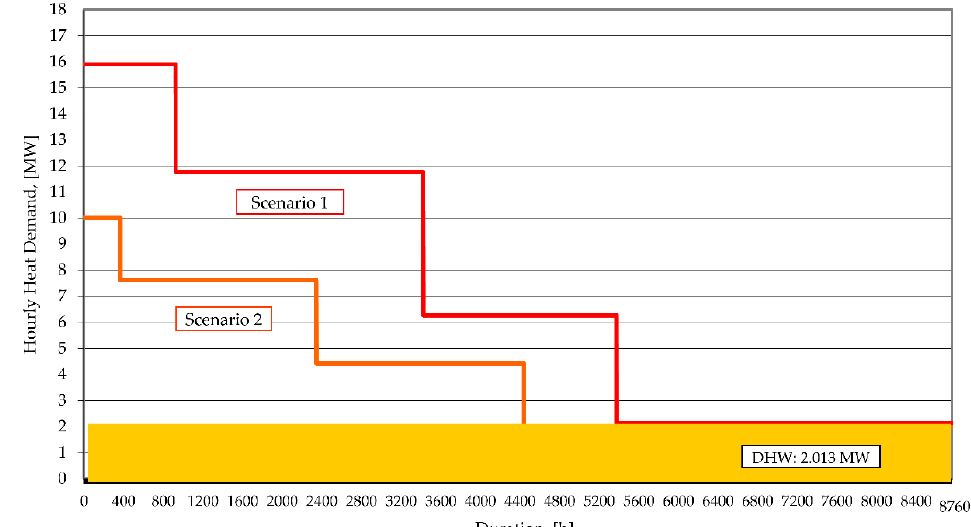
Figure 4. Ranked curves of the annual energy t demands of the urban areas for the study scenarios under a transitory regime